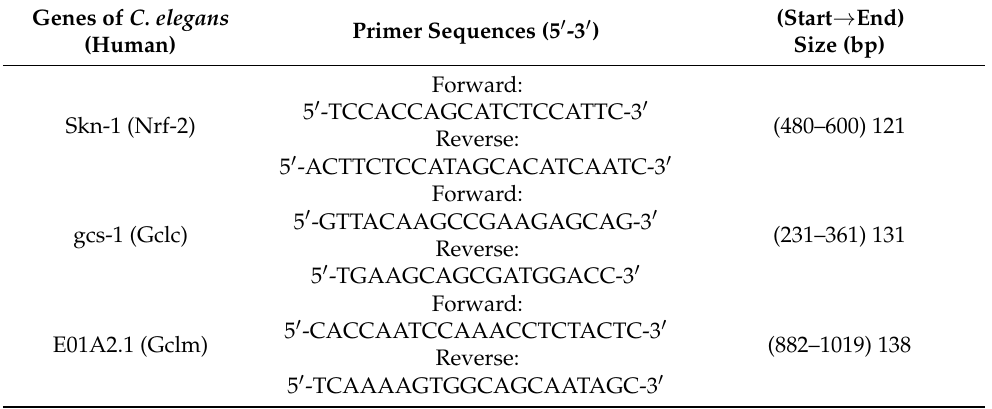
Table 1. Primers for